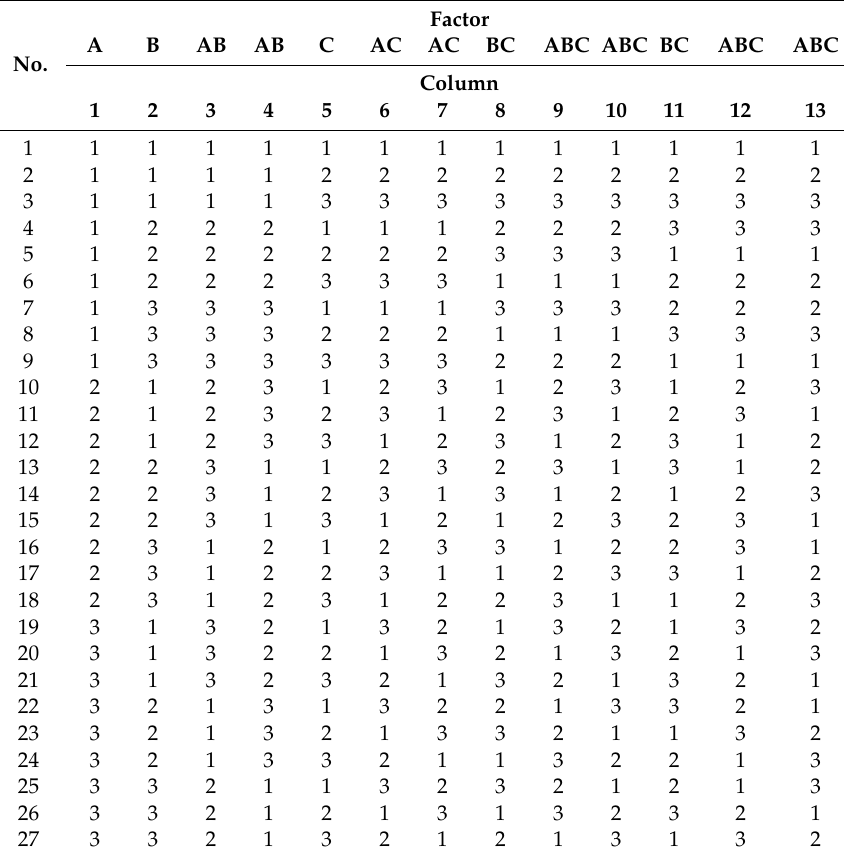
Table 3. Orthogonal array for interaction